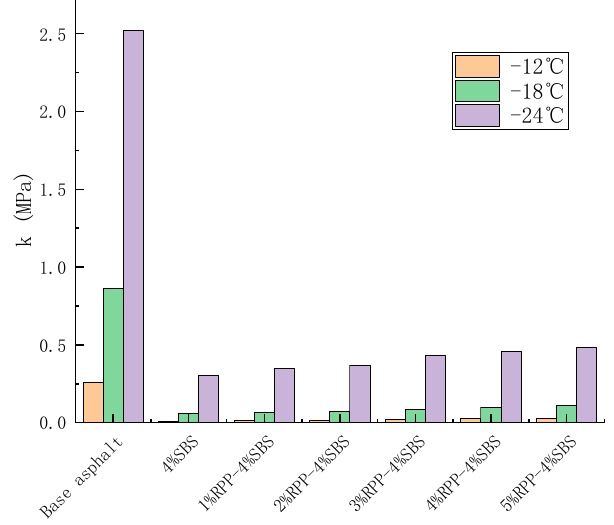
asphalt 4%SBS 1%RPP-4%SBS 2%RPP-4%SBS 3%RPP-4%SBS 4%RPP-4%SBS 5%RPP-4%SBS Base Figure 16. Effect of RPP content on the k index of modified Figure 16. Effect of RPP content on the k index of modified asphalt.